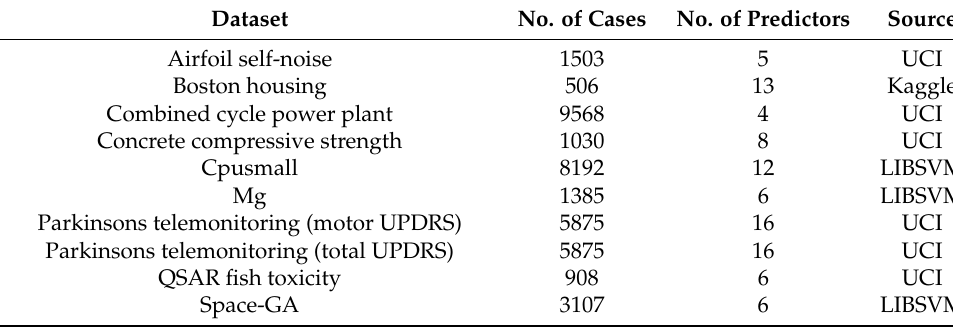
Table 1. Description of the